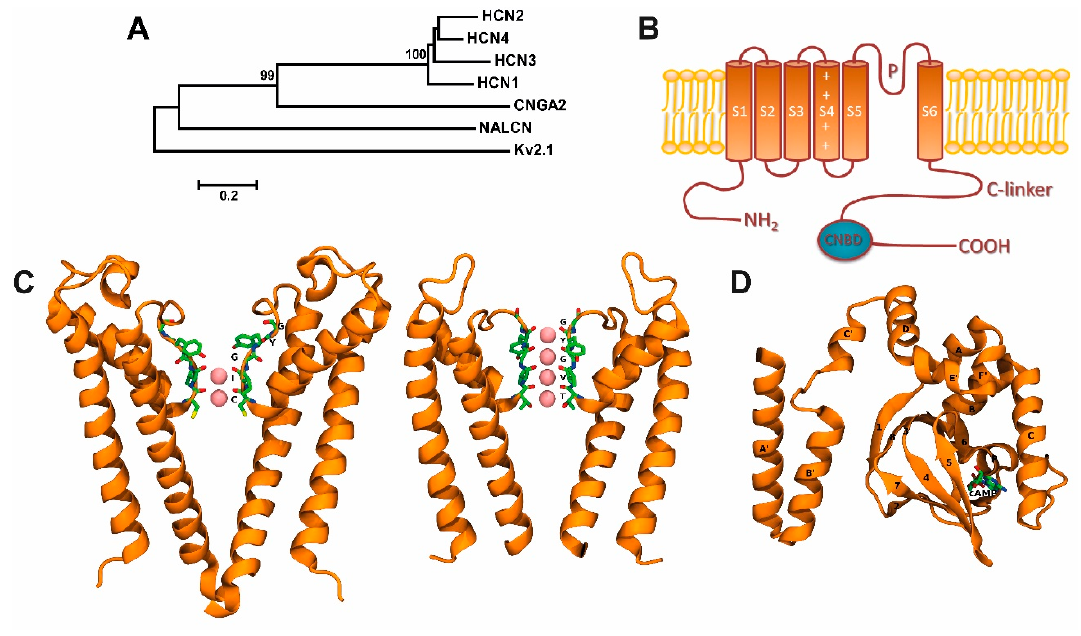
Figure 1. Hyperpolarization-activated cyclic nucleotide-gated (HCN) channels and their two- and three-dimensional structures: ( A ) Phylogenetic tree showing proteins in the human HCN channel family. It includes selected ion channels of Kv (voltage-gated K + channel), NALCN (sodium leak channel, non-selective), and CNG (cyclic nucleotide-gated ion channel) families. Phylogenetic analysis was carried out with Molecular Evolutionary Genetics Analysis version 5 (MEGA5) software (www.megasoftware.net.) free of charge. Lines length, scaled below the tree, indicate the relative distance between nodes. Numbers on branches indicate bootstrap values (as a percentage). ( B ) Topological model proposed for HCN channels. Each subunit has one pore forming domain (P-loops) and six transmembrane domains (denoted S1–S6). The C-terminus of each subunit contains a cyclic nucleotide-binding domain (CNBD) connected to the sixth transmembrane α -heli x (S6) via the C-linker. ( C ) Left, HCN filter structure (Protein Data Bank, PDB: 5U6O [4]) in a ribbon representation, showing a weak K + -selective filter—K + ion occupancy: 3 and 4 sites-. Right, KcsA filter structure (PDB:1K4C), showing a K + selective filter—K + ion occupancy: 1 to 4 sites-. The K + ions in both filters, they are represented as pink spheres. A view of the K + selectivity filter structure is shown on the right ( D ) cAMP-bound CNBD structure view (PDB:1Q5O [32]) in ribbon representation showing a cAMP molecule in a stick representation. Bothe C and D were prepared using PyMOL software version 2.0